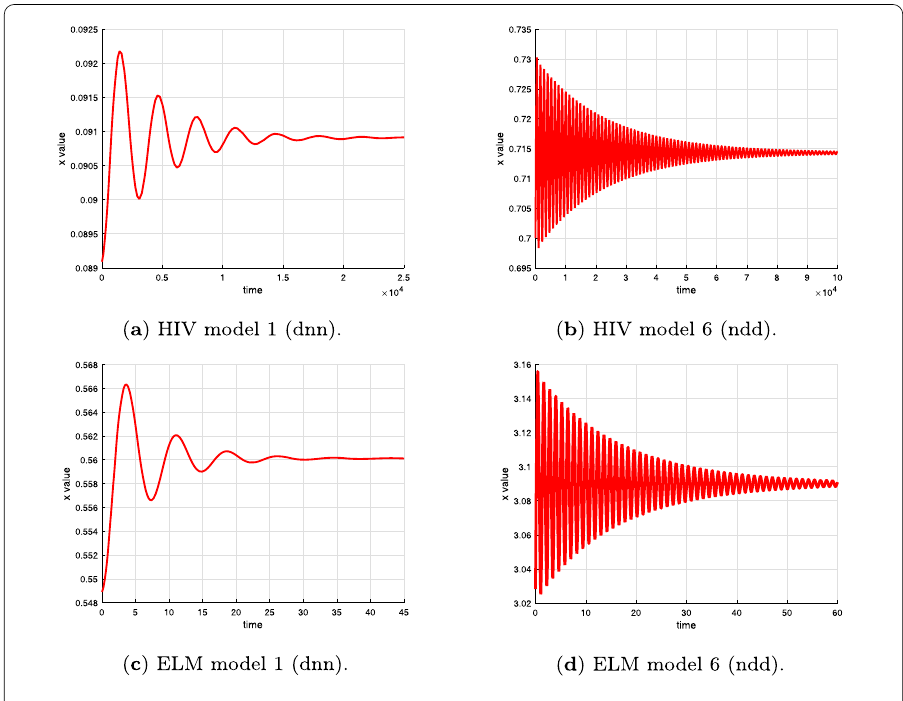
Figure 3 Solutions of HIV and ELM differential equations versions 1 and 6 for time delay less than critical delay τ < τ c (see Tables 11 and 12)